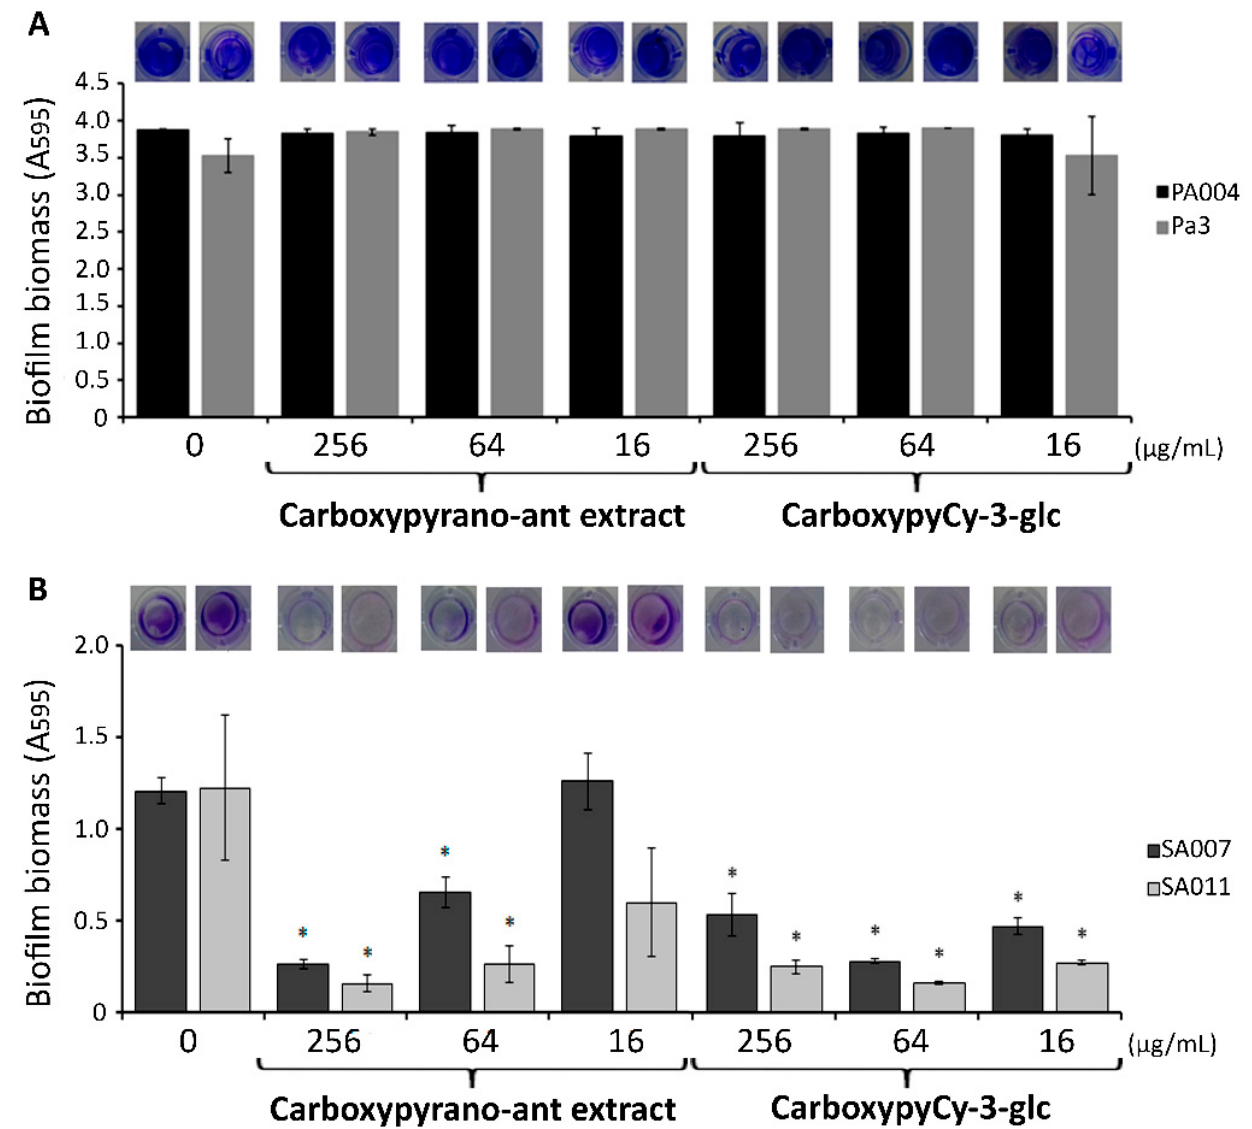
Figure 1. Biomass quantification using the crystal violet assay of ( A ) PA004 and Pa3 and ( B ) SA007 and SA011 biofilms formed in presence of carboxypyrano-ant extract and carboxypyCy-3-glc at 256, 64 and 16 µ g/mL, and in absence of any compound or extract (control). Error bars represent SEM. Differences between the experimental groups and the respective controls were statistically significant for * p < 0.05.